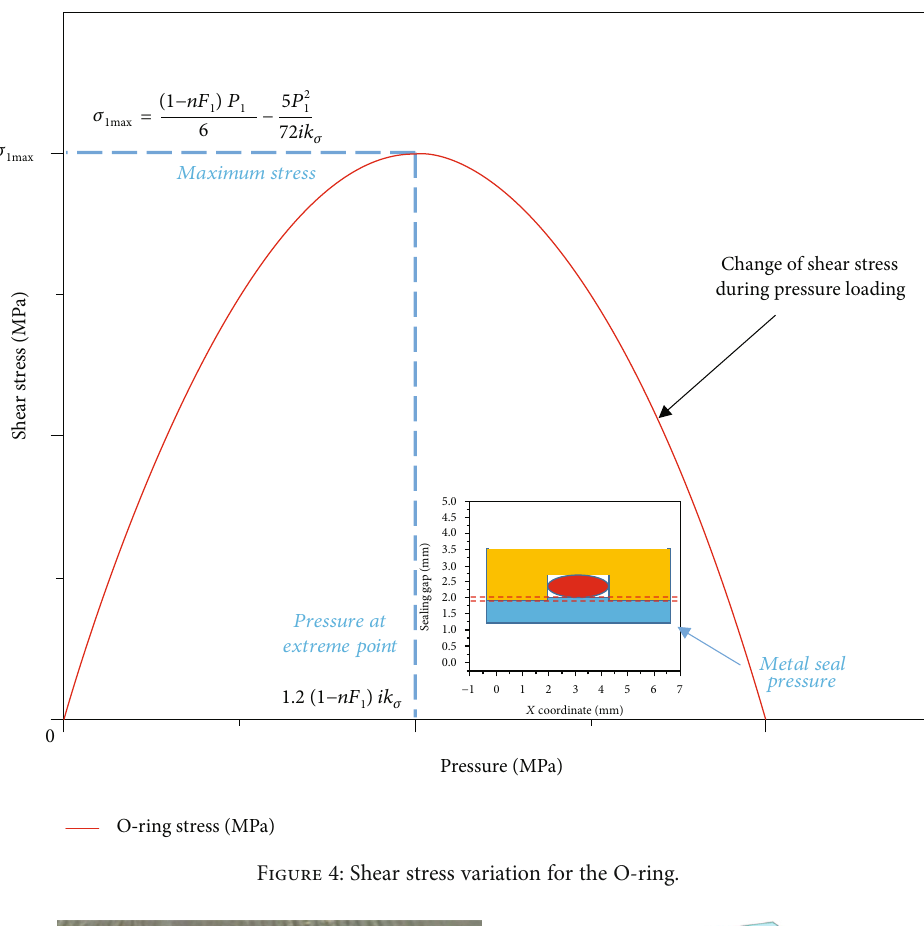
Figure 4: Shear stress variation for the O-ring.